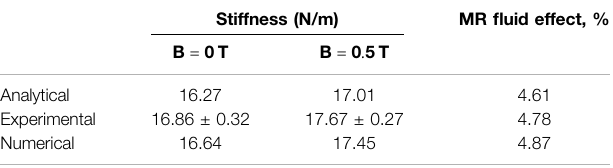
TABLE 2 | Static performance of MR fl uid fi lled